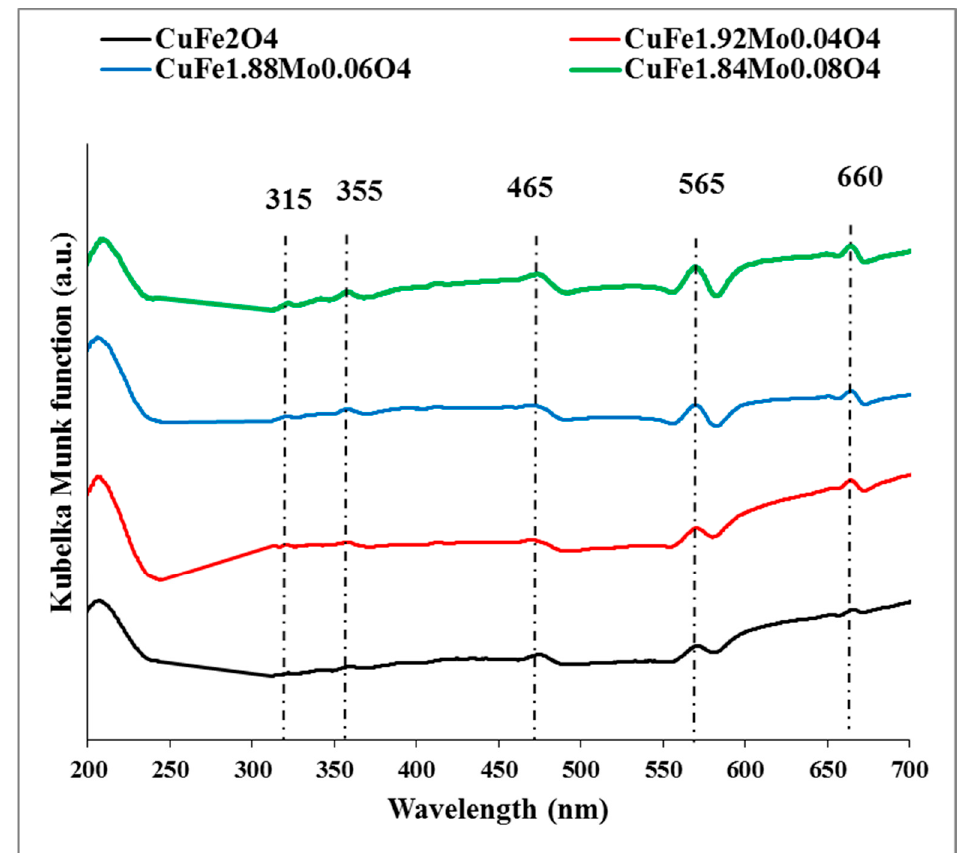
Figure 3. UV–Vis absorption spectra of the copper–molybdenum ferrites.